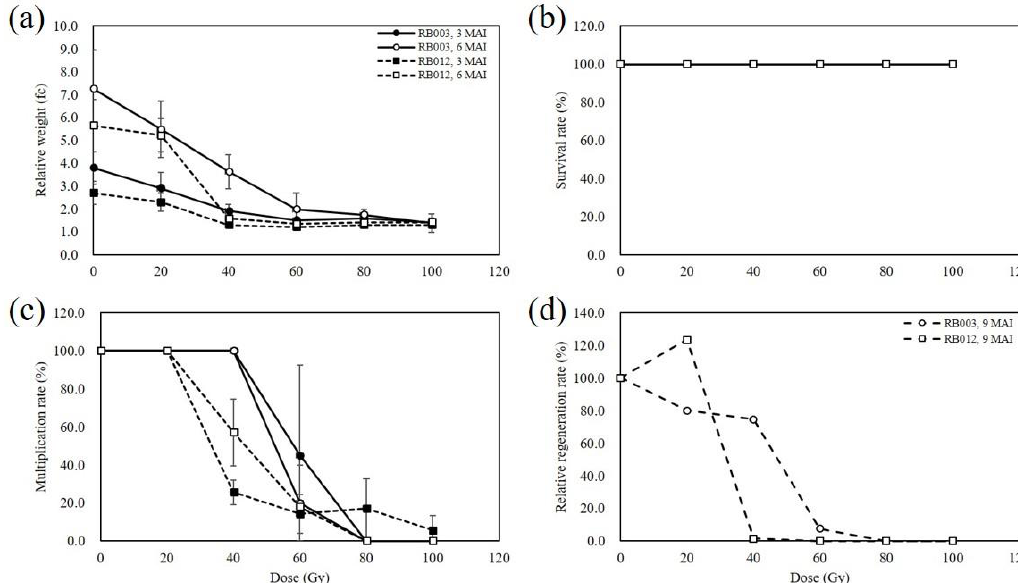
Figure 1. Relative weight, survival, multiplication, and relative regeneration rate of Cymbidium hybrids, RB003 and RB012 rhizomes at 3, 6, and 9 months after γ -irradiation. ( a ) Relative weight of rhizomes; ( b ) survival rate of rhizomes; ( c ) multiplication rate of rhizomes; ( d ) relative regeneration rate of rhizomes. Relative weight, survival, and multiplication rate of rhizomes were measured at 3 and 6 months after irradiation, whereas the relative regeneration rate was analyzed at 9 months. fc, fold-change. MAI, months after irradiation. Error bars indicate the standard error of the mean (n = 5).